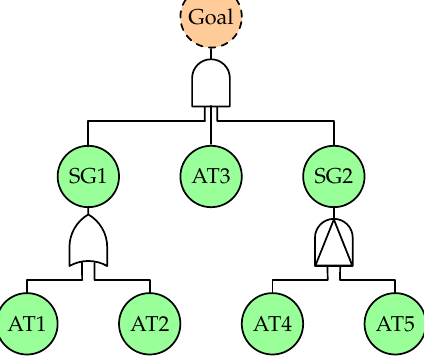
Figure 1. The Attack tree